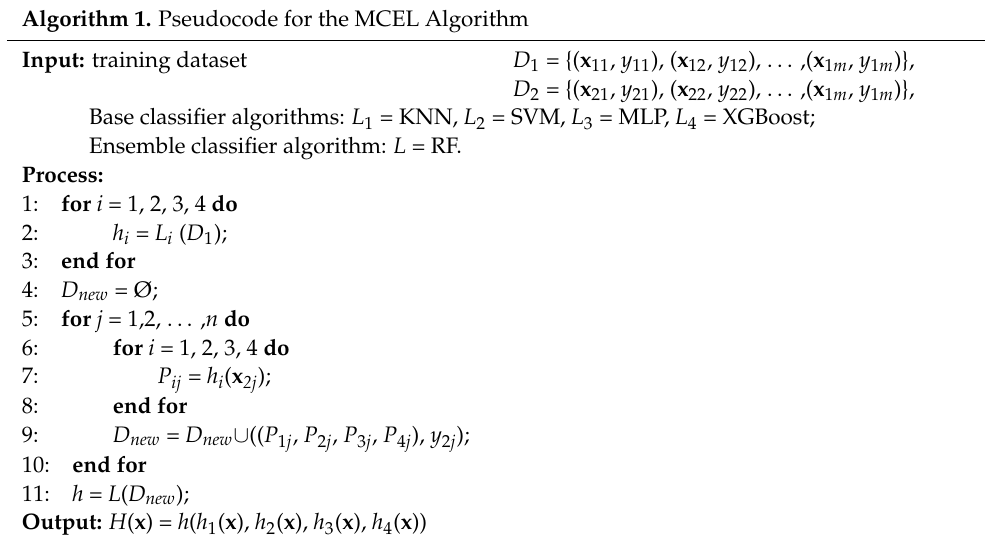
Algorithm 1. Pseudocode for the MCEL